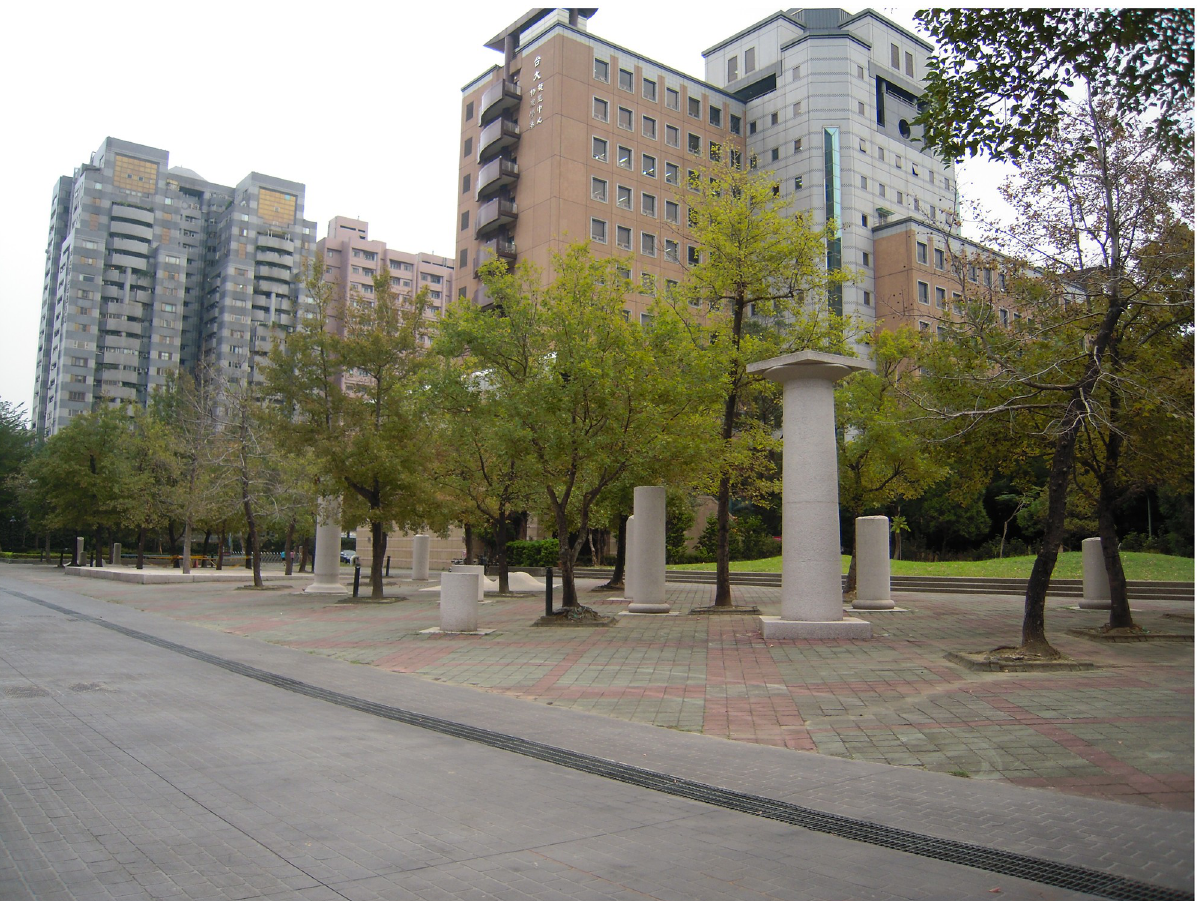
Fig 2. The built environment within natural surroundings where primary students usually practice